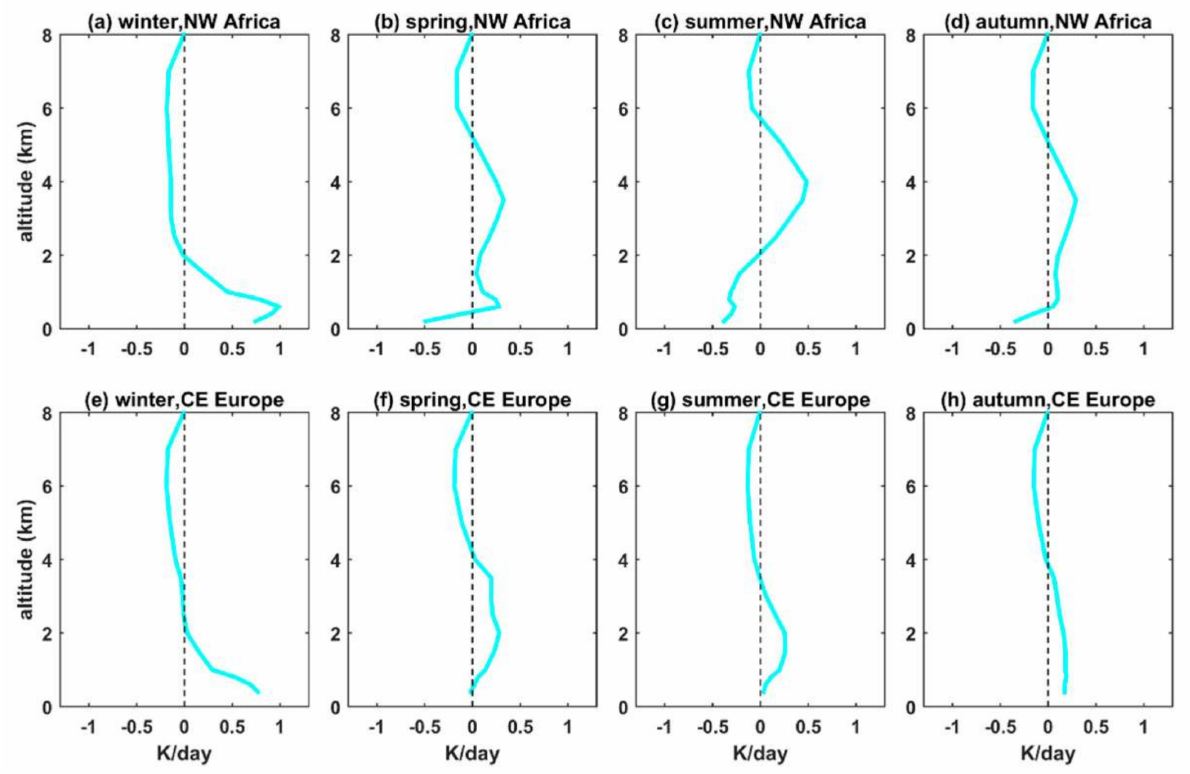
Figure 10. Change (in %) in the HR (realistic—default) in the first 8 km of the atmosphere due to the use of the LIVAS profiles instead of the default libRadtran profile. Results are for SZA = 60 ◦ . The corresponding graphs for 30 ◦ and 80 ◦ are provided in Appendix A.